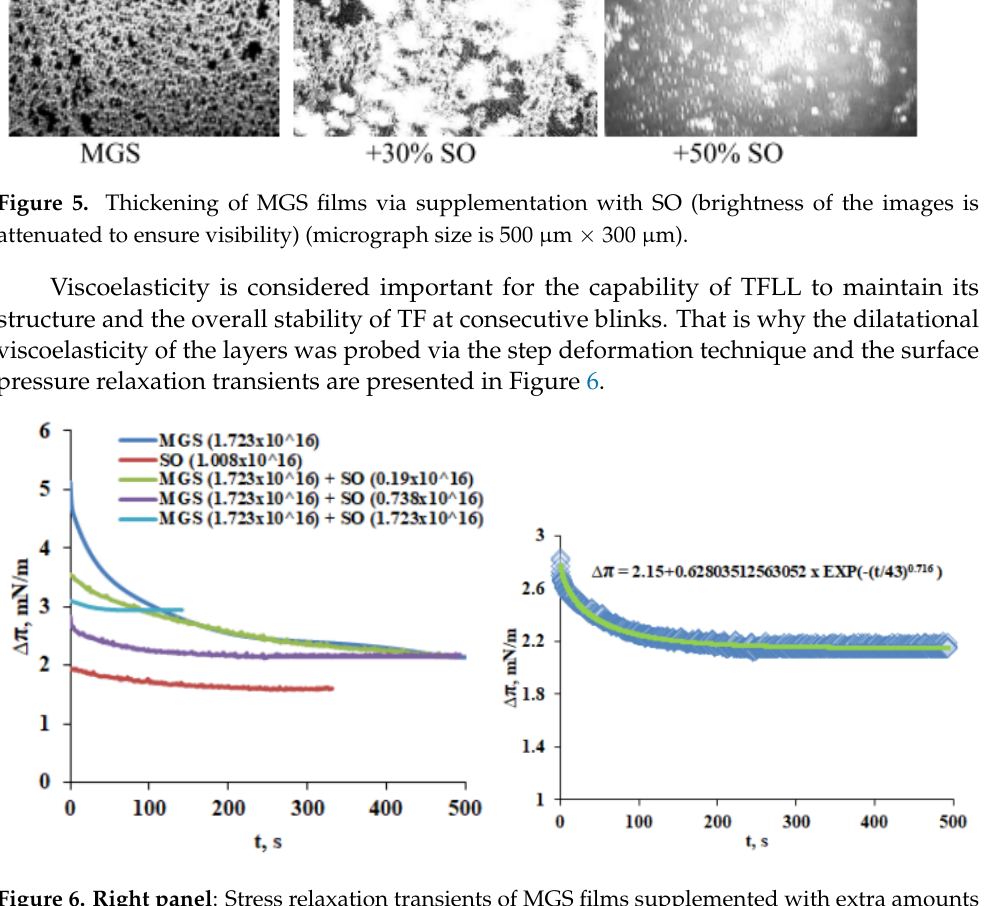
Figure 6. Right panel : Stress relaxation transients of MGS films supplemented with extra amounts of SO. The numbers in brackets denote the total number of MGS and SO molecules deposited at the trough surface. Left panel : Stress relaxation transient fitted with Kohlrausch–Williams–Watts (KWW) equation (Equation